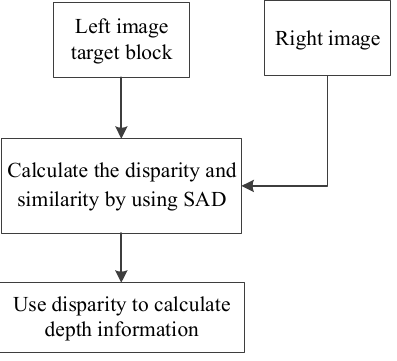
Figure 2. Stereo matching flowchart.